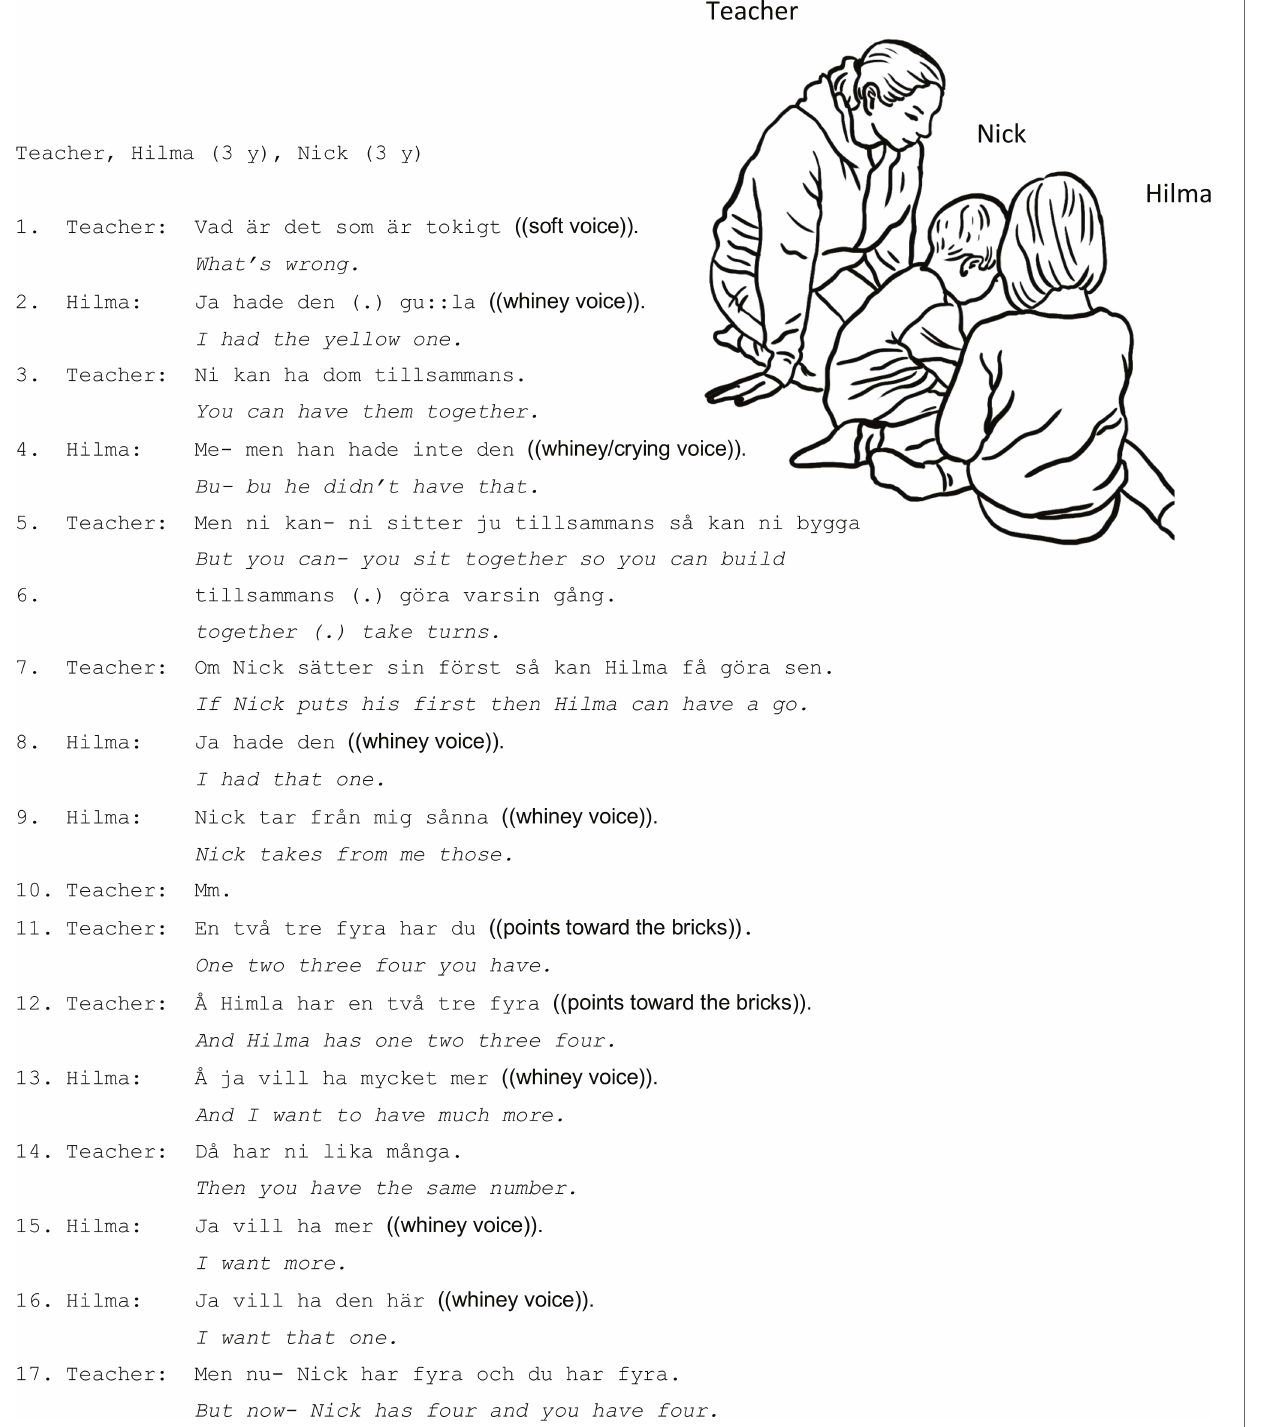
FIGURE 5 | Excerpt